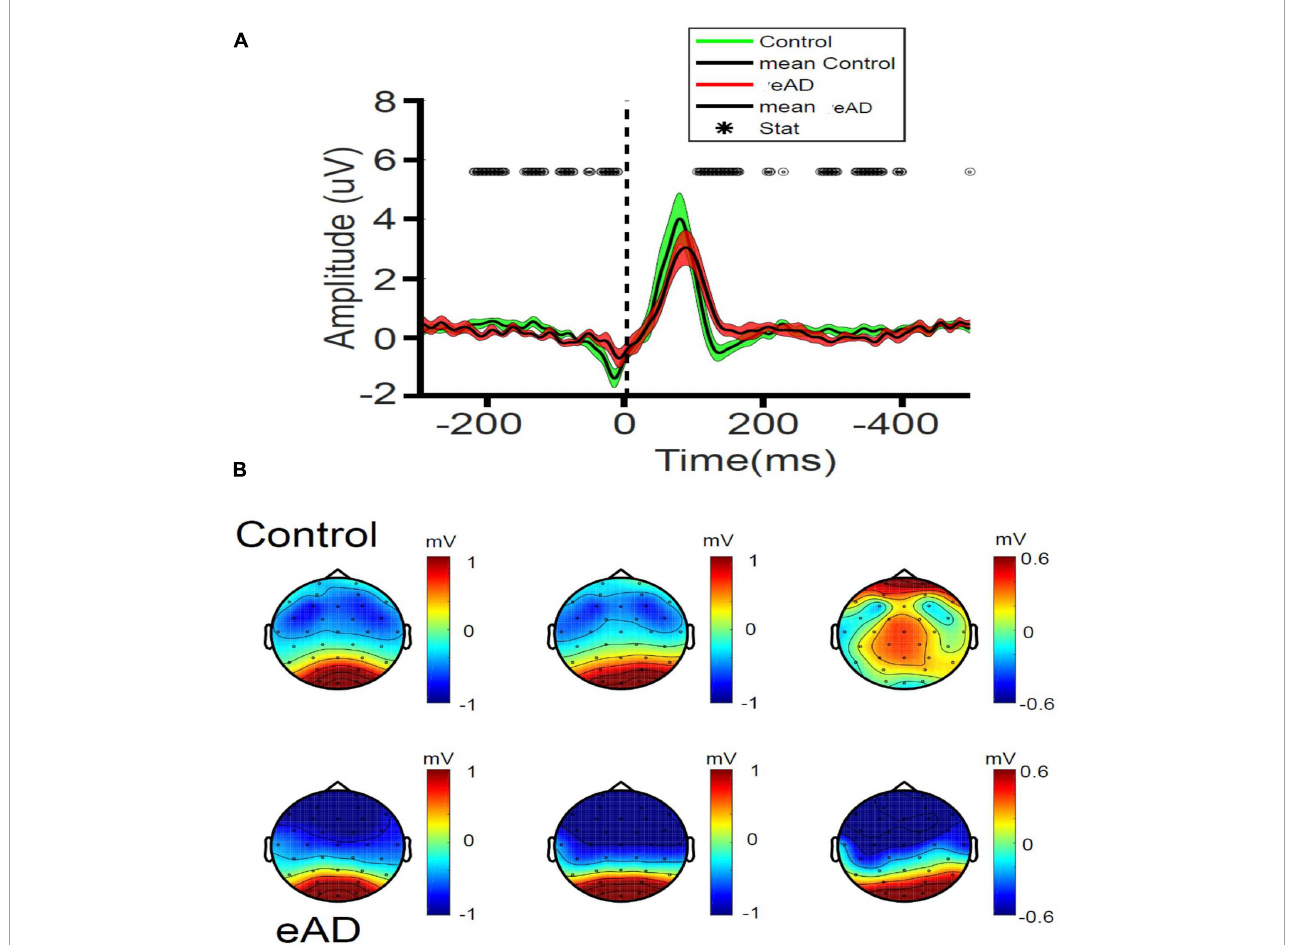
FIGURE3 Fixation related potentials (RPs) recorded in early Alzheimer’s disease (eAD) and control participants. (A) Amplitude of the occipital potentials (mean of O1, O2, and Oz channels). The central black line represents the mean, and the colored shade the variance. For each curve, time 0 represents the onset of visual fixation. Statistical differences in time are indicated as black open circles at the top (Wilcoxon test, ∗ p < 0.05). For panels (A,B) , red represents eAD patients ( n = 9); and green, elderly controls ( n = 9). (B) Scalp topographic maps of fixational-event RPs (fERPs) recorded at 60, 100, and 135 ms post-fixation. 2-D spatial color maps of voltage scalp distributions of fERP (in µ V), from negative (blue) to positive voltages (red), at different latencies after the onset of fixation, are shown. Almost no spreading of the occipital dipole to parietal or frontoparietal regions is observed at later latencies in the eAD group compared to the control